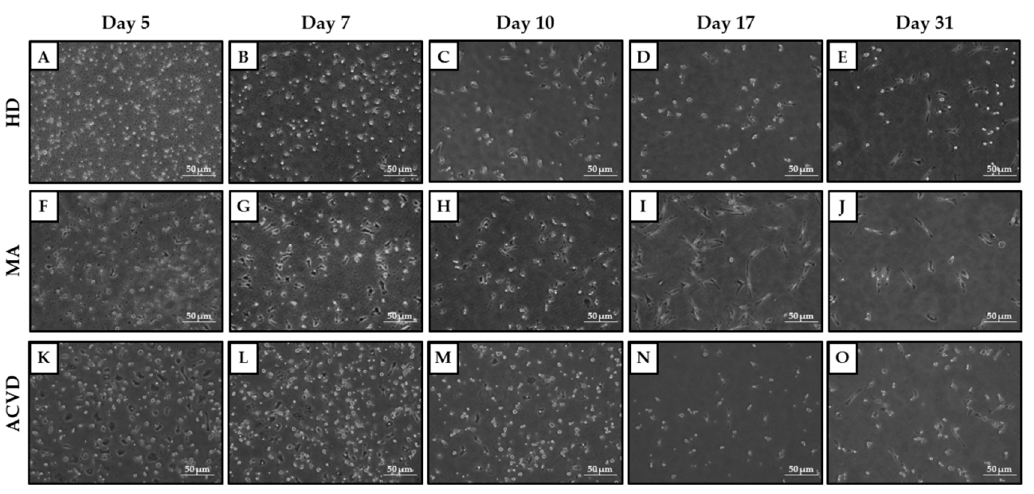
Figure 1. Endothelial progenitor cell (EPC) level in whole blood (WB) from ( A ) a heterogeneous and ( B ) a homogeneous (adult, Caucasian, non-operated) group of Moyamoya angiopathy (MA) patients, as compared with healthy donors (HD) and atherosclerotic cerebrovascular disease (ACVD) controls: Data are expressed as mean of circulating endothelial progenitor cell (cEPC)% ± standard deviation (SD), where cEPC% was calculated as follows: (cEPCs/µL/WB cells/µL) × 100; statistical significance (* p < 0.05) was calculated through Student’s t -test ( p = 0.032).